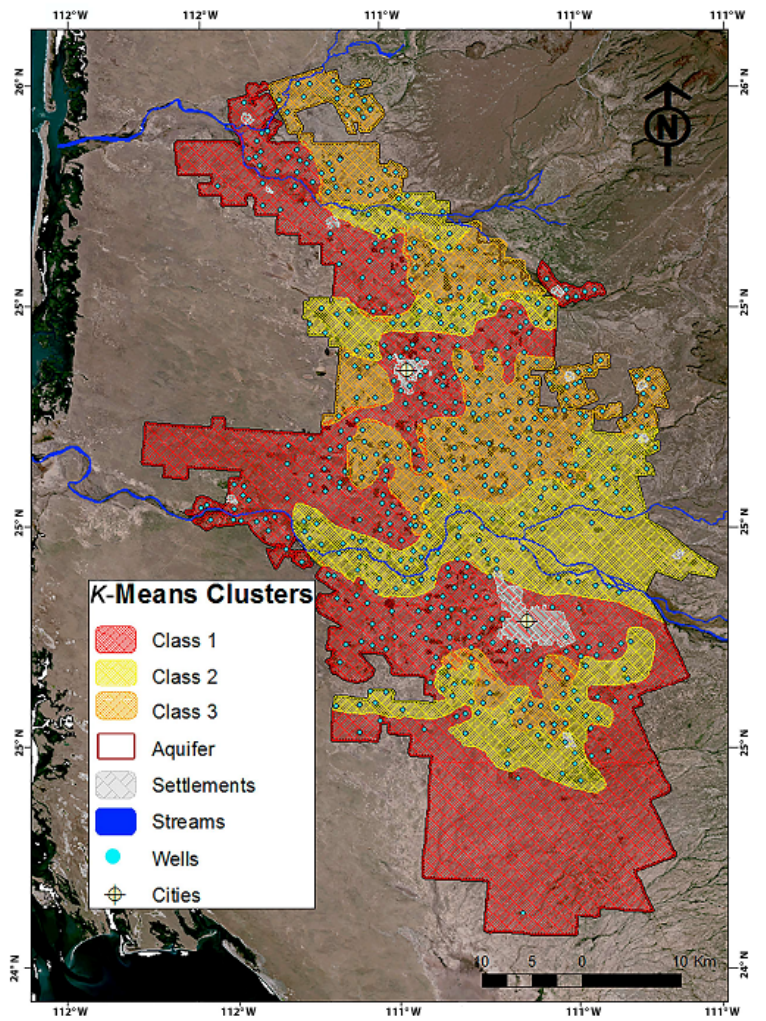
Figure 8. Spatial distribution of clusters: class 1, class 2 and class